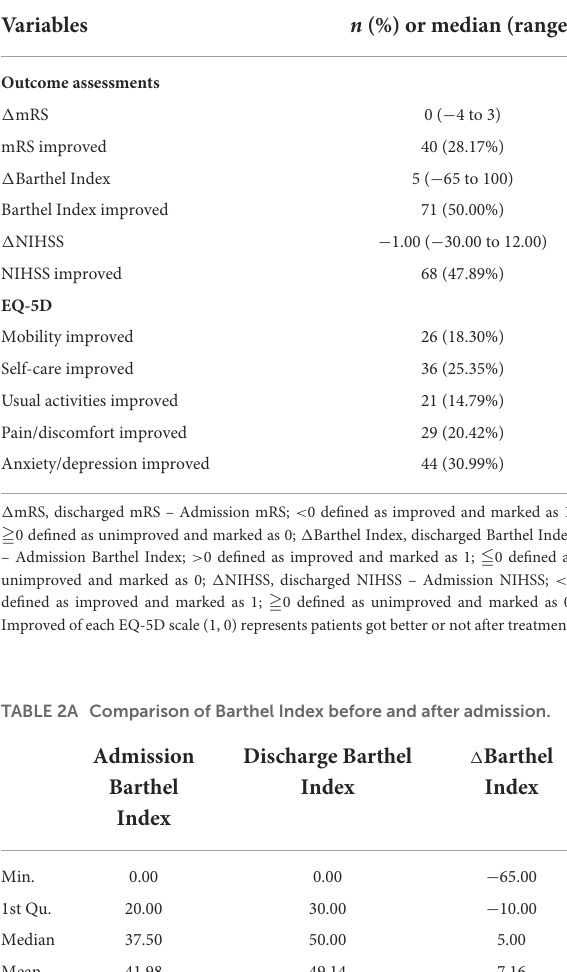
TABLE 1B Baseline patients’ carotid duplex datasets. TABLE 1C Outcome assessments and EQ-5D results.